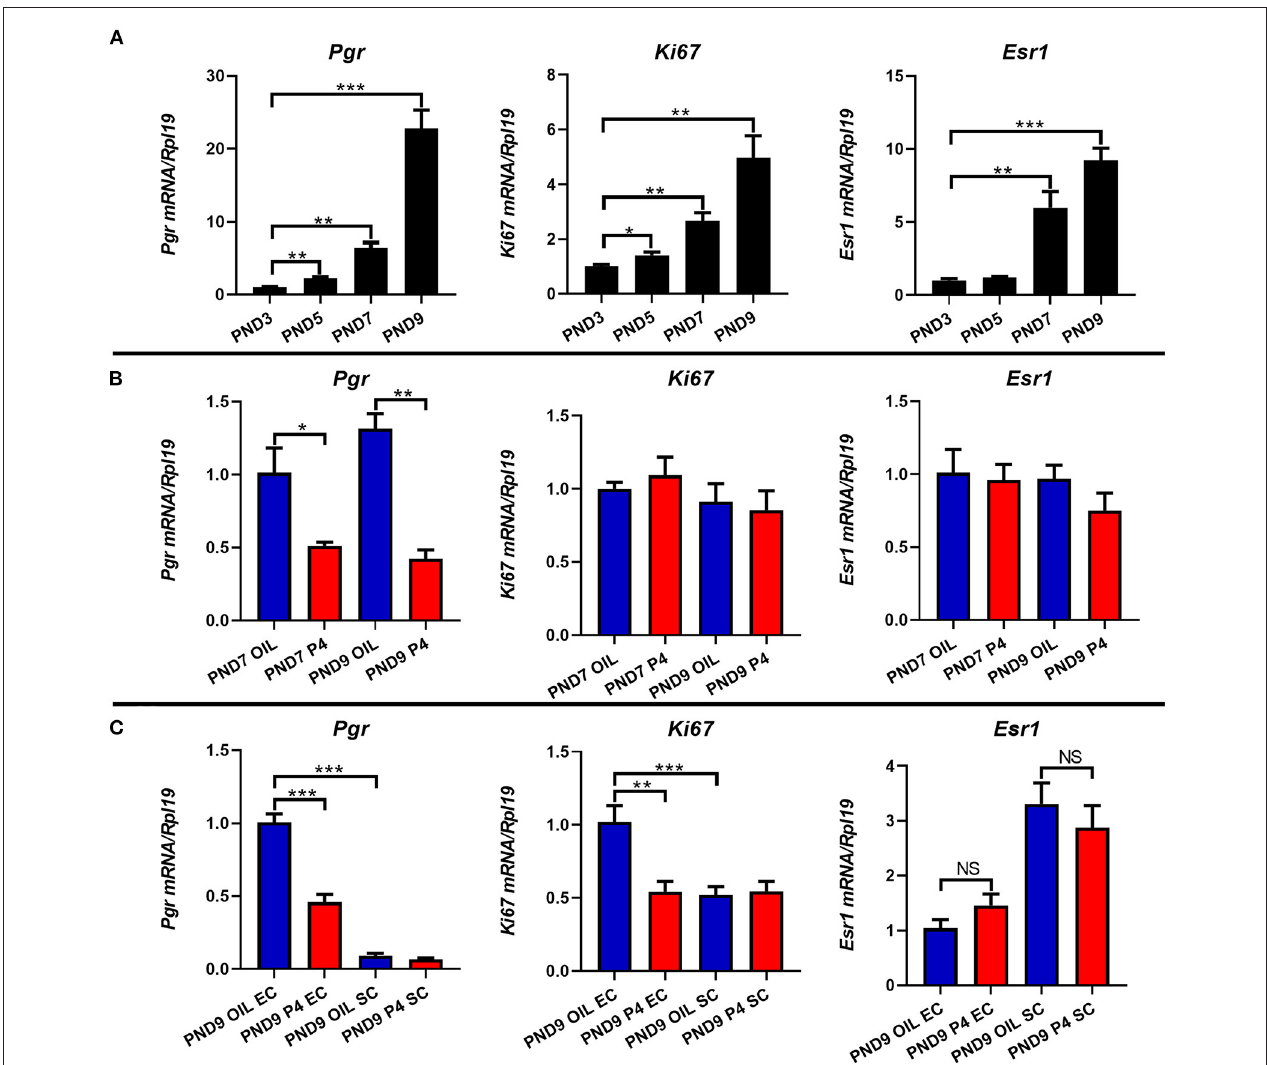
FIGURE 8 | Effects of endometrial gland dysgenesis on the expression of cell proliferation, Pgr , Esr1 . The expressions of Ki67 , Pgr , and Esr1 on PND3, PND5, PND7, and PND9 (A) . Comparison of Ki67 , Pgr , and Esr1 genes’ expression after treated with P4 or Sesame oil on PND7 and PND9 (B) . The mRNA level of Ki67 , Pgr , and Esr1 in endometrial epithelium or stroma after treated with P4 or Sesame oil on PND9 (C) . Results are means ± SEM ( n = 5). Bars with different superscripts are significantly different ( P <